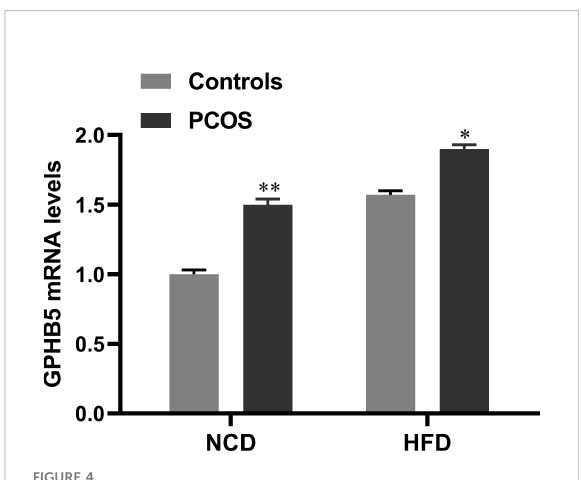
FIGURE 4 mRNA expression of GPHB5 in the liver of NCD- or HFD-fed WT or PCOS rats. Data are means ± SD. * p< 0.05; ** p< 0.01 vs.